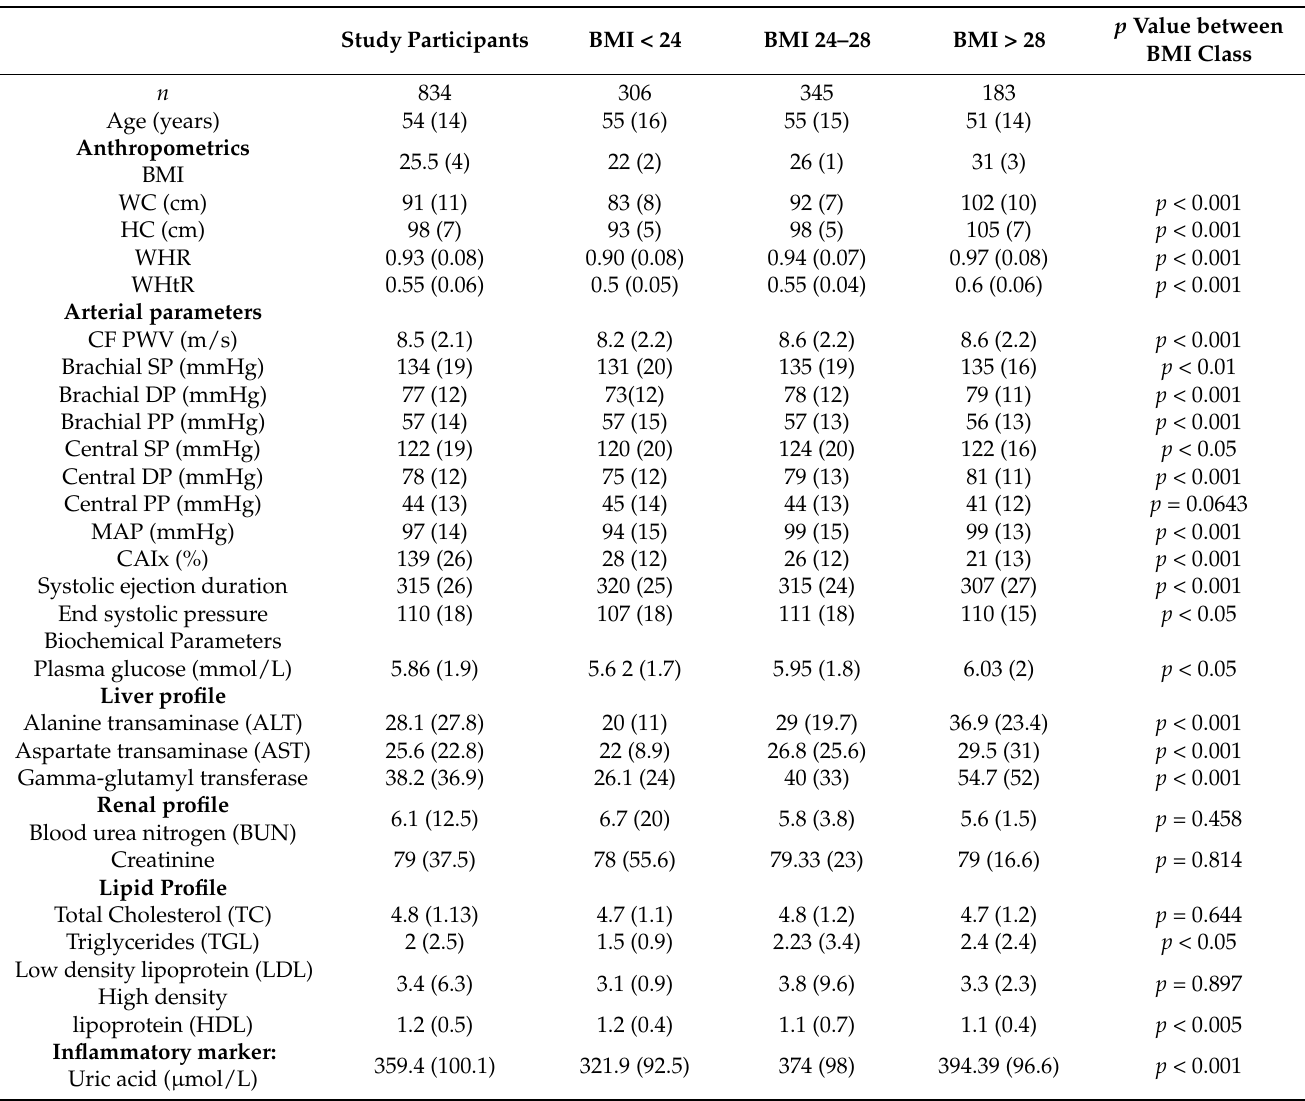
Table 1. Continuous clinical characteristics of the patient cohort. Data are given as mean ± SD. BMI, body mass index; WC, waist circumference; HC, hip circumference, WHR, waist–hip ratio; WHtR, waist–height ratio; CF PWV, carotid femoral pulse wave velocity;